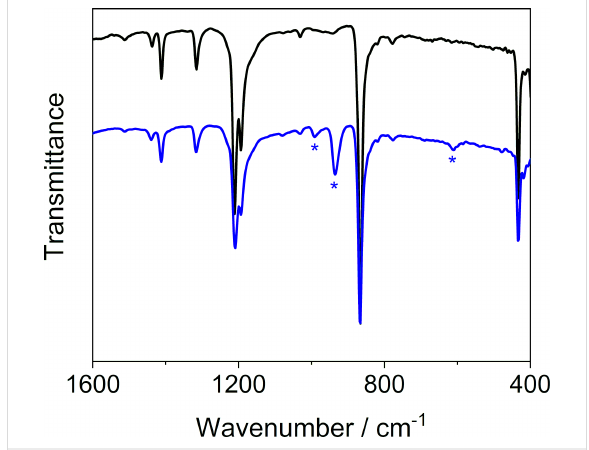
Figure 2: FTIR spectra of MFU-4 before (black) and after (Sample 3a, blue) the loading of SF 6 . Bands attributed to SF 6 are marked with an